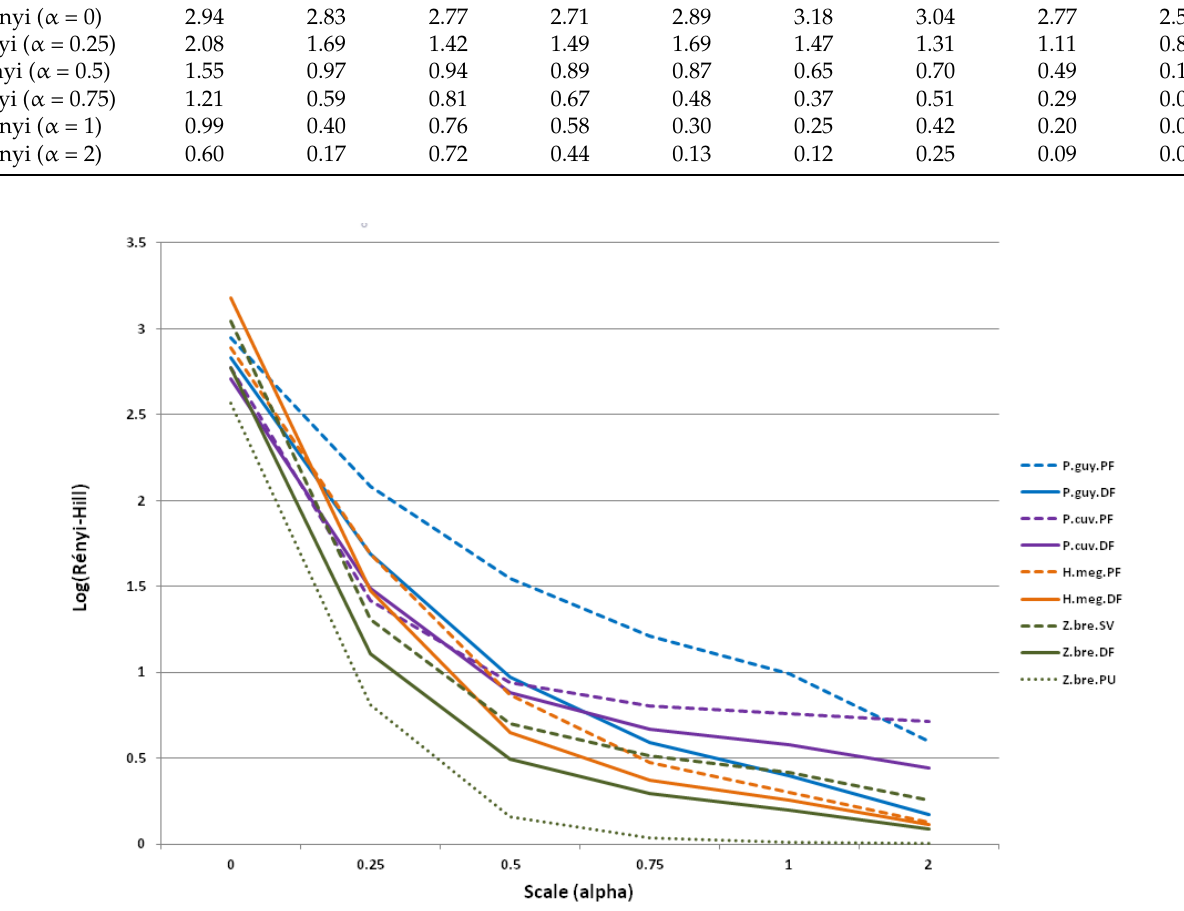
Figure 3. Ordination plot of Rényi’s entropy values by scale numbers ( α = 0, 0.25, 0.5, 0.75, 1, and 2) for the four species present in different types of habitats (nine species–habitat combinations). Pristine forest and savannah are represented by dashed lines, disturbed forest by solid lines, and peri-urban areas by the dotted line. P.guy.PF: Proechimys guyannensis from pristine forest, P.guy.DF: Proechimys guyannensis from disturbed forest , P.cuv.PF: Proechimys cuvieri from pristine forest , P.cuv.DF: Proechimys cuvieri from disturbed forest, H.meg.PF: Hylaeamys megacephalus from pristine forest, H.meg.DF: Hylaeamys megacephalus from pristine forest, Z.bre.SV: Zygodontomys brevicauda from savannah, Z.bre.DF: Zy- godontomys brevicauda from disturbed forest, Z.bre.PU: Zygodontomys brevicauda from peri-urban areas. Table 3. Richness and Rényi’s entropy values for different values of α between 0 and 2 for the nine species–habitat com- binations.